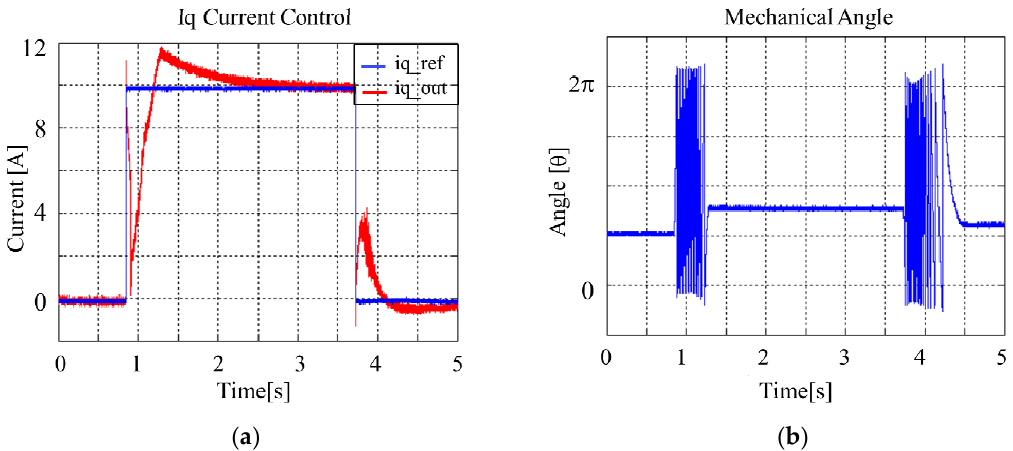
Figure 11. EMB experimental results: ( a ) Iq axis current control; ( b ) mechanical rotation angle.